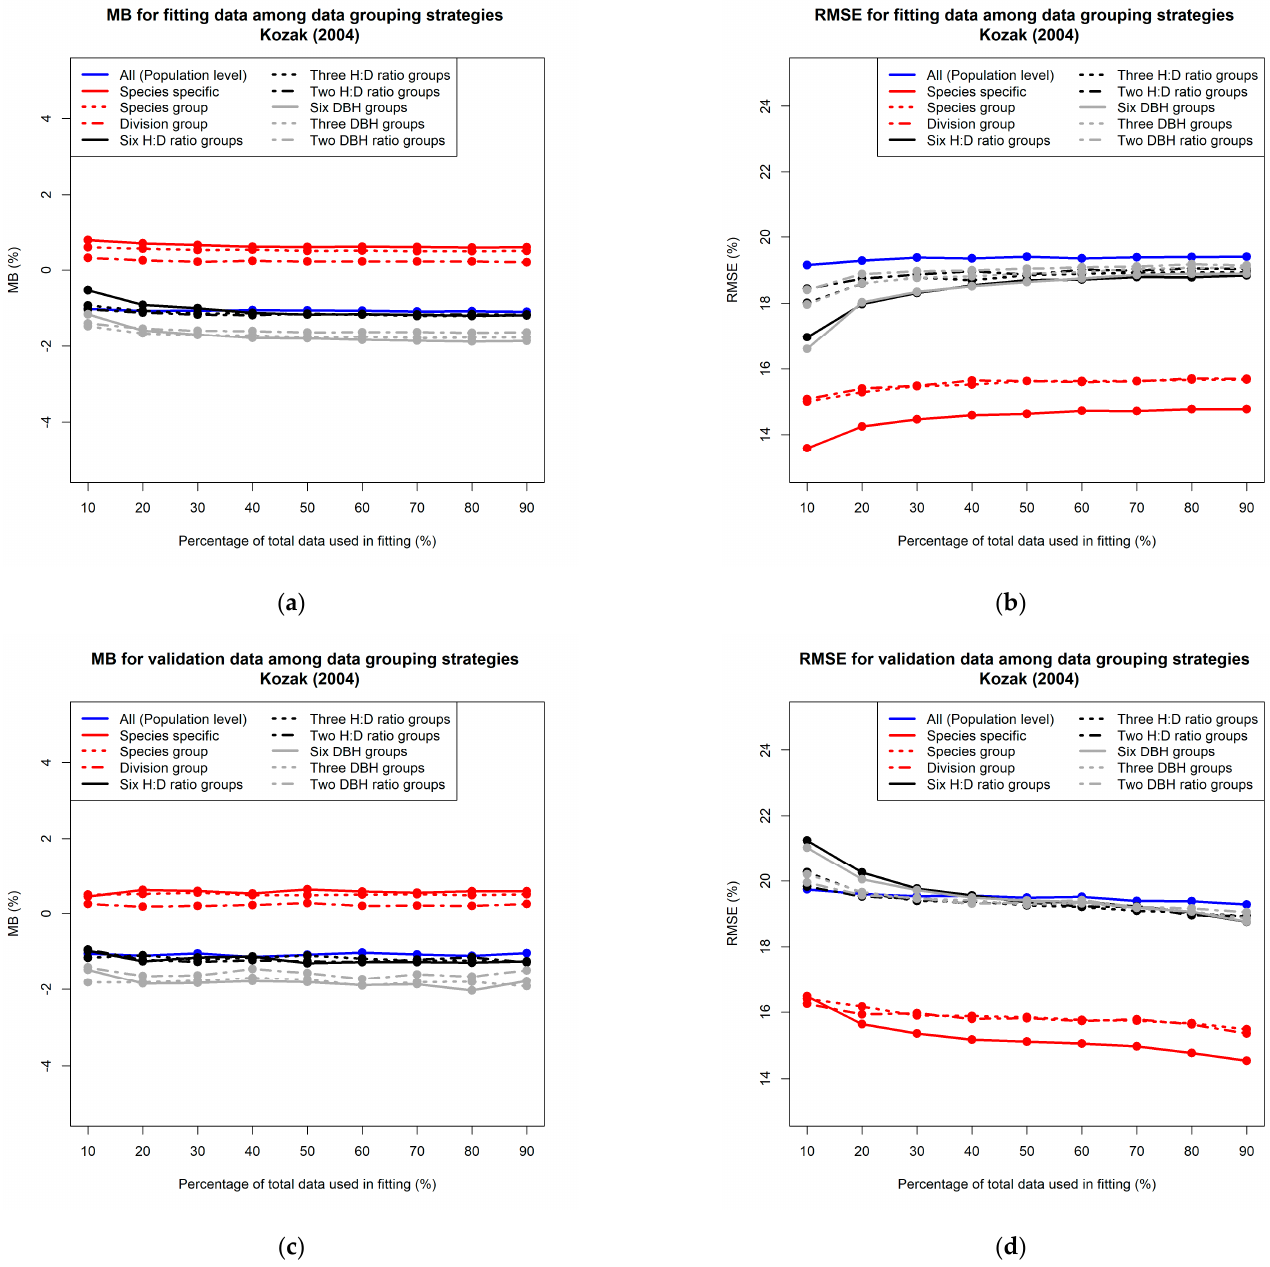
Figure 2. Summary of percent mean bias (MB) and percent root mean square error (RMSE) among data grouping strategies by Kozak (2004) model. Fitting/validation datasets were split as 10/90, 20/80, 30/70, 40/60, 50/50, 60/40, 70/30, 80/20 and 90/10 (%), respectively. ( a ) MB, fitting, ( b ) RMSE, fitting, ( c ) MB, validation, ( d ) RMSE, validation.